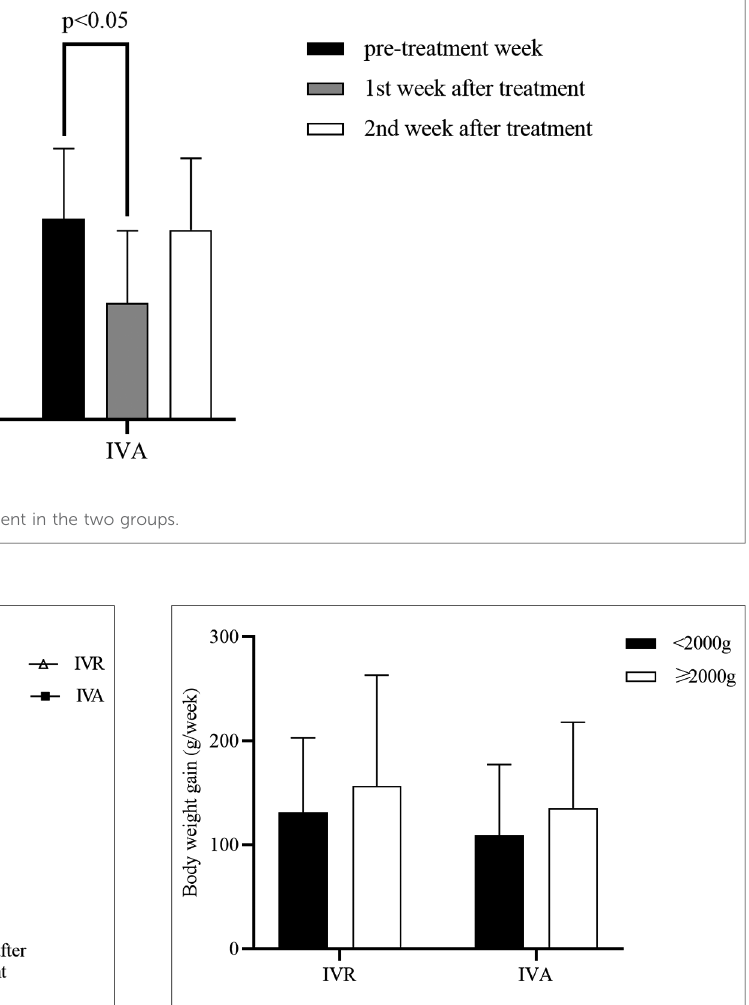
FIGURE 2 Comparison of weekly BW gain between the two groups.